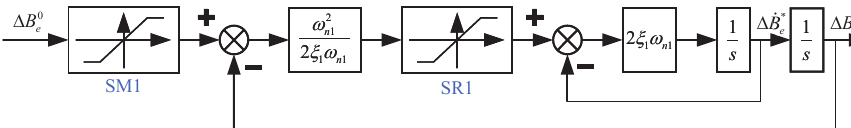
Figure 2. Schematic diagram of the command filter strategy applied on ∆ B 0 e